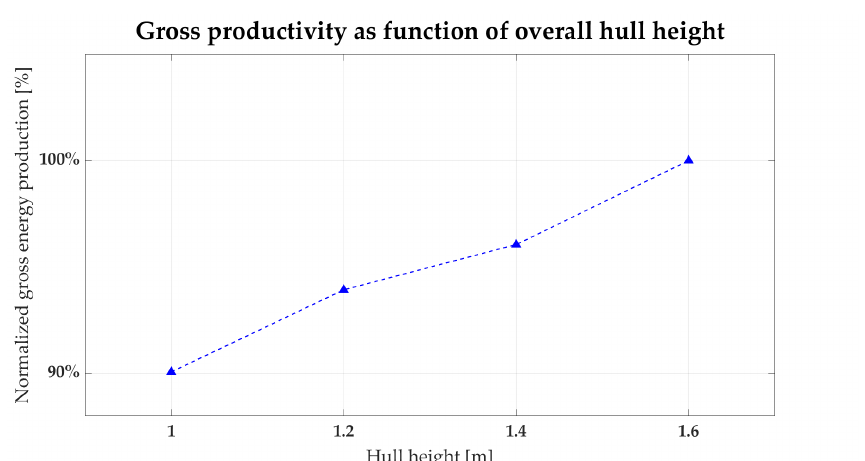
Figure 10. Gross productivity as function of overall hull